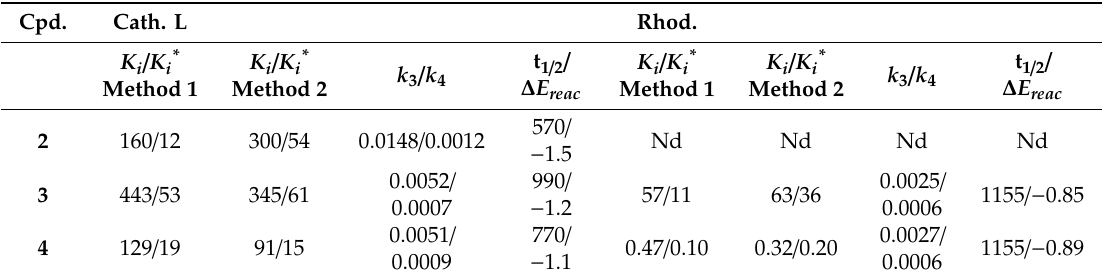
Table 2. Detailed inhibition data for the time-dependent inhibition of cathepsin L and rhodesain by 1,4-naphthoquinone (NQ)-derived inhibitors of the general structure NQ-NH- l -Phe- l -Leu-OR 1 . . Cpd. Cath. L